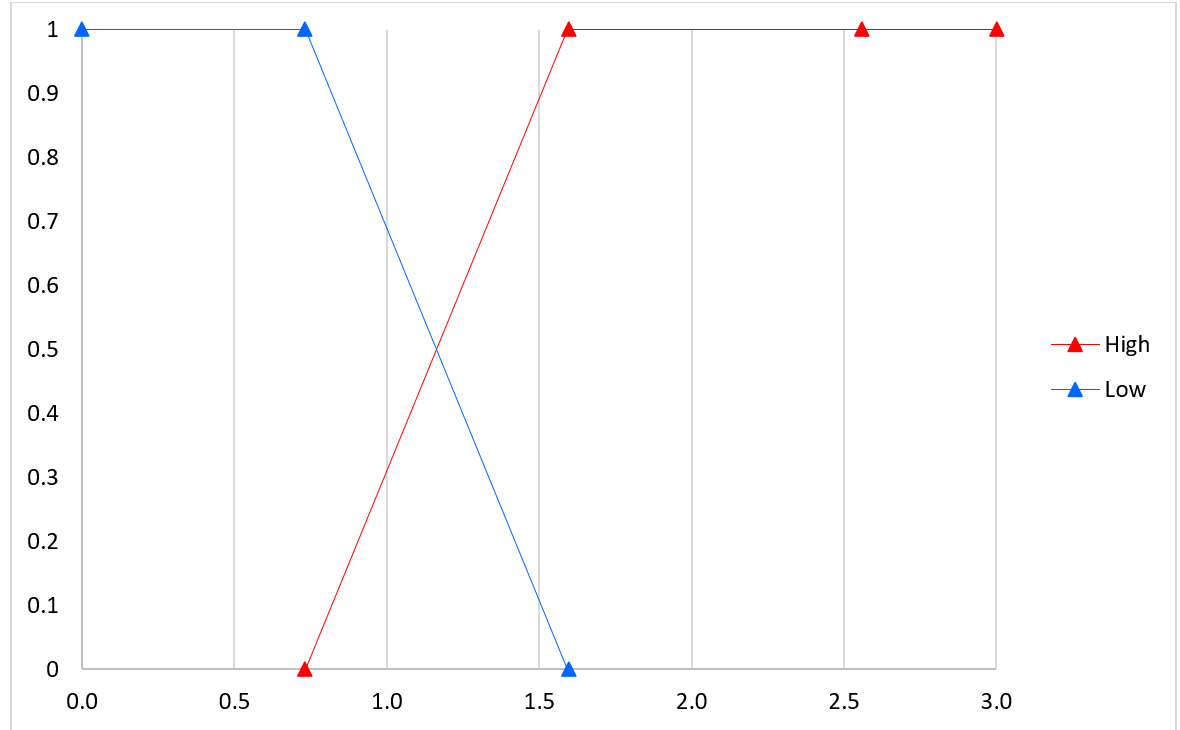
Figure 7. Membership functions of stakeholders’